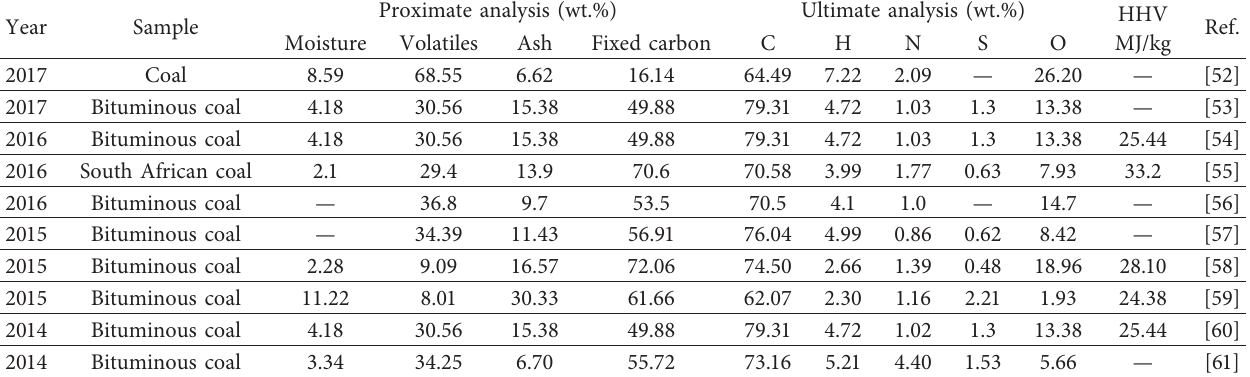
Table 1: Elemental and chemical composition of coal.